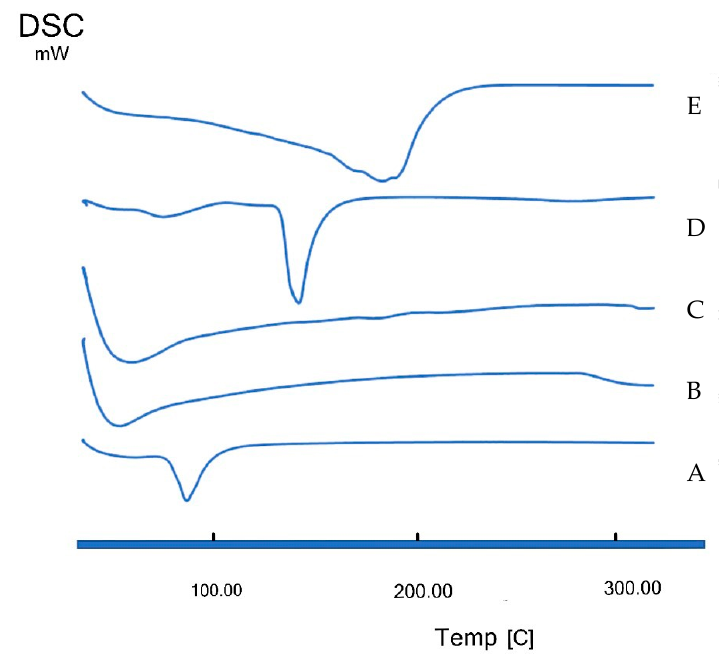
Figure 5. DSC thermograms of Compritol ® ( A ), Miglyol ® ( B ), Span 20 ( C ), ZMP ( D ) and NLC9 ( E ) at a heating rate of 10 °C/min up to 300 °C.